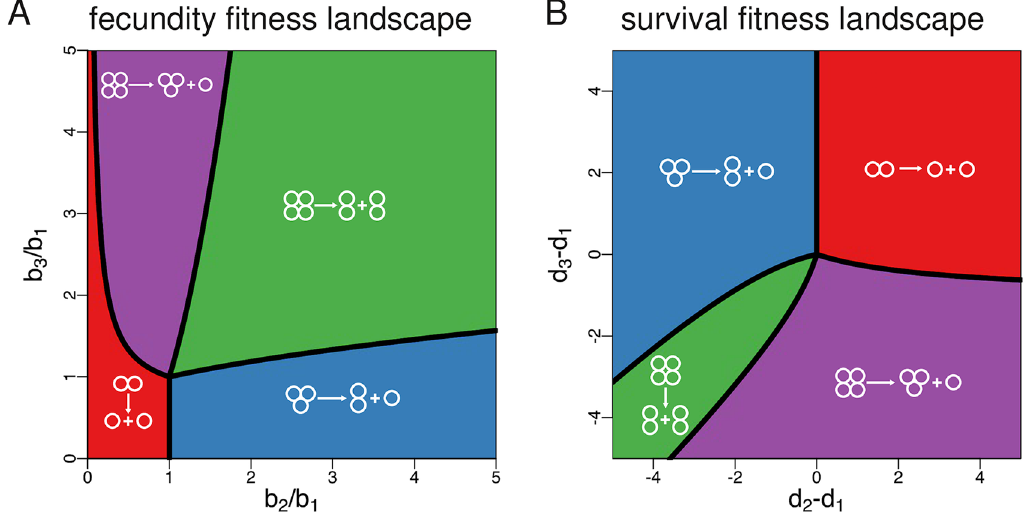
Fig 3. Optimal fragmentation modes for fecundity and survival landscapes (costless fragmentation). A Life cycles achievingthe maximum populationgrowth rate for n = 4 under fecundity landscapes (i.e., d 1 = d 2 = d 3 = 0). In this scenario, fragmentation mode 2+2 is optimal for most fitness landscapes. B Life cycles achievingthe maximum populationgrowth rate for n = 4 under survival landscapes (i.e., b 1 = b 2 = b 3 = 1). In this scenario,fragmentation modes emitting a unicellular propagule (1+1, 2+1, 3+1) are optimalfor most parameter values. We use ratios of birth rates and differencesbetween death rates as axes becauseone can consider b 1 = 1 and min( d 1 , d 2 , d 3 ) = 0 without loss of generality(S1 Text, AppendixD). Shadedareas are obtainedfrom the direct comparisonof numerical solutions,lines are found analytically (S1 Text, AppendixF).